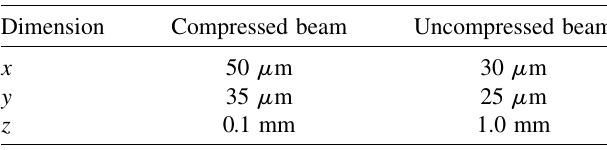
TABLE I. rms sizes of the compressed and uncompressed electron beams at the interaction point.